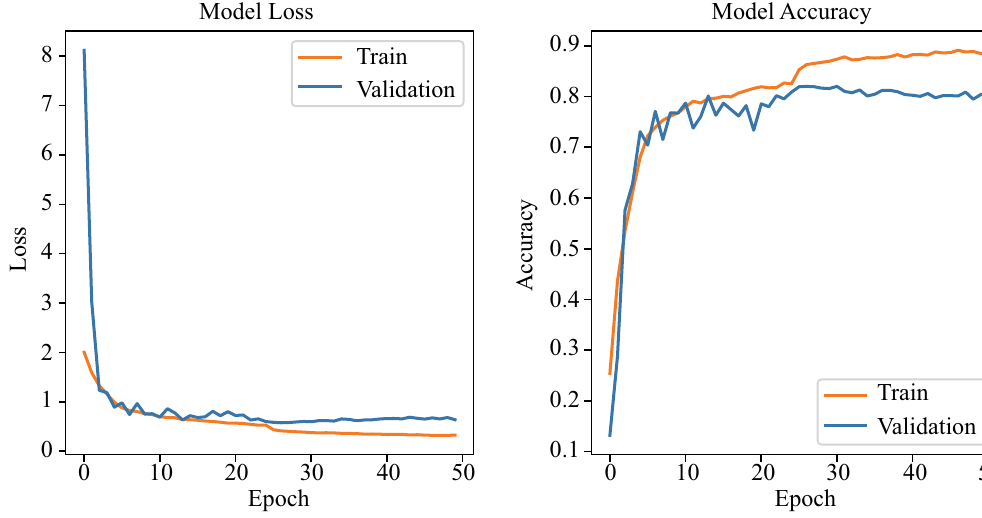
Figure 6. Training/validation set loss and accuracy curve for CPSC2018.